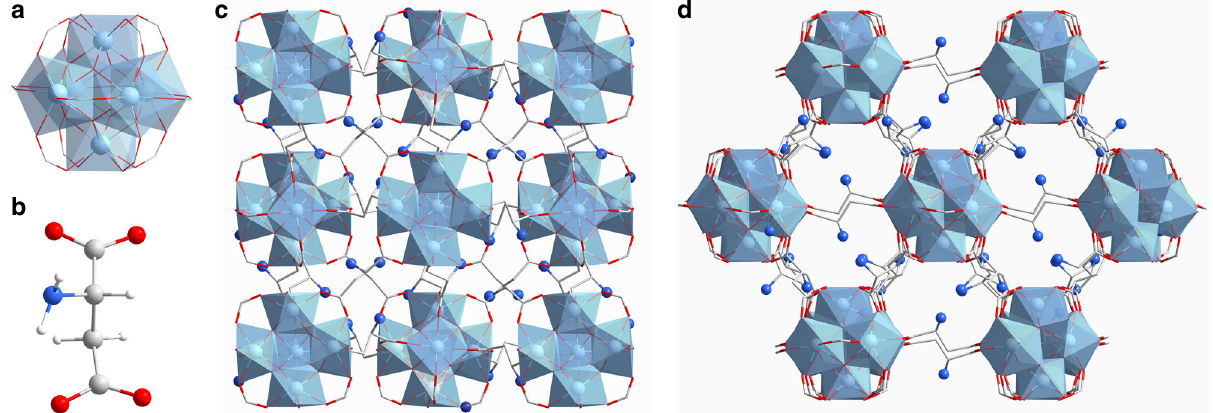
Fig. 1 Crystal structural features of MIP-202(Zr). a The 12-connected Zr 6 ( µ 3 -O) 4 ( µ 3 -OH) 4 (COO − ) 12 cluster SBU. b An aspartic acid linker. c The crystal structure of MIP-202(Zr) viewed along the a -axis. d The crystal structure of MIP-202(Zr) viewed along the (101) plane. Zr atoms or polyhedra, oxygen, carbon, nitrogen, and hydrogen atoms are in light blue, red, gray, dark blue, and